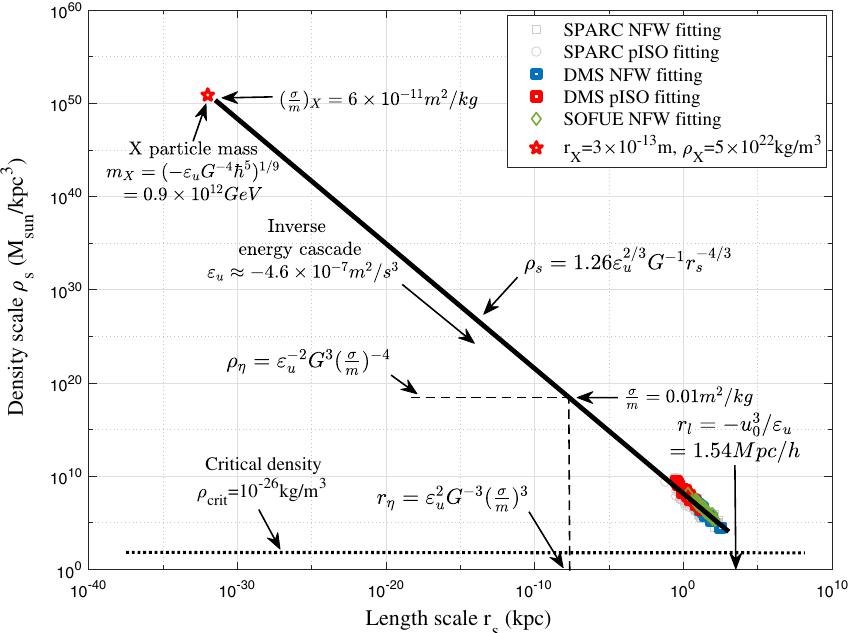
Figure 8. For fully collisionless dark matter, we may extend the predicted − 4/3 law in Fig. 6 to the smallest scale where quantum effect can be important (red star). On this scale, dark matter particles properties are determined by three constants: ε u , G , and Planck constant (cid:31) 52